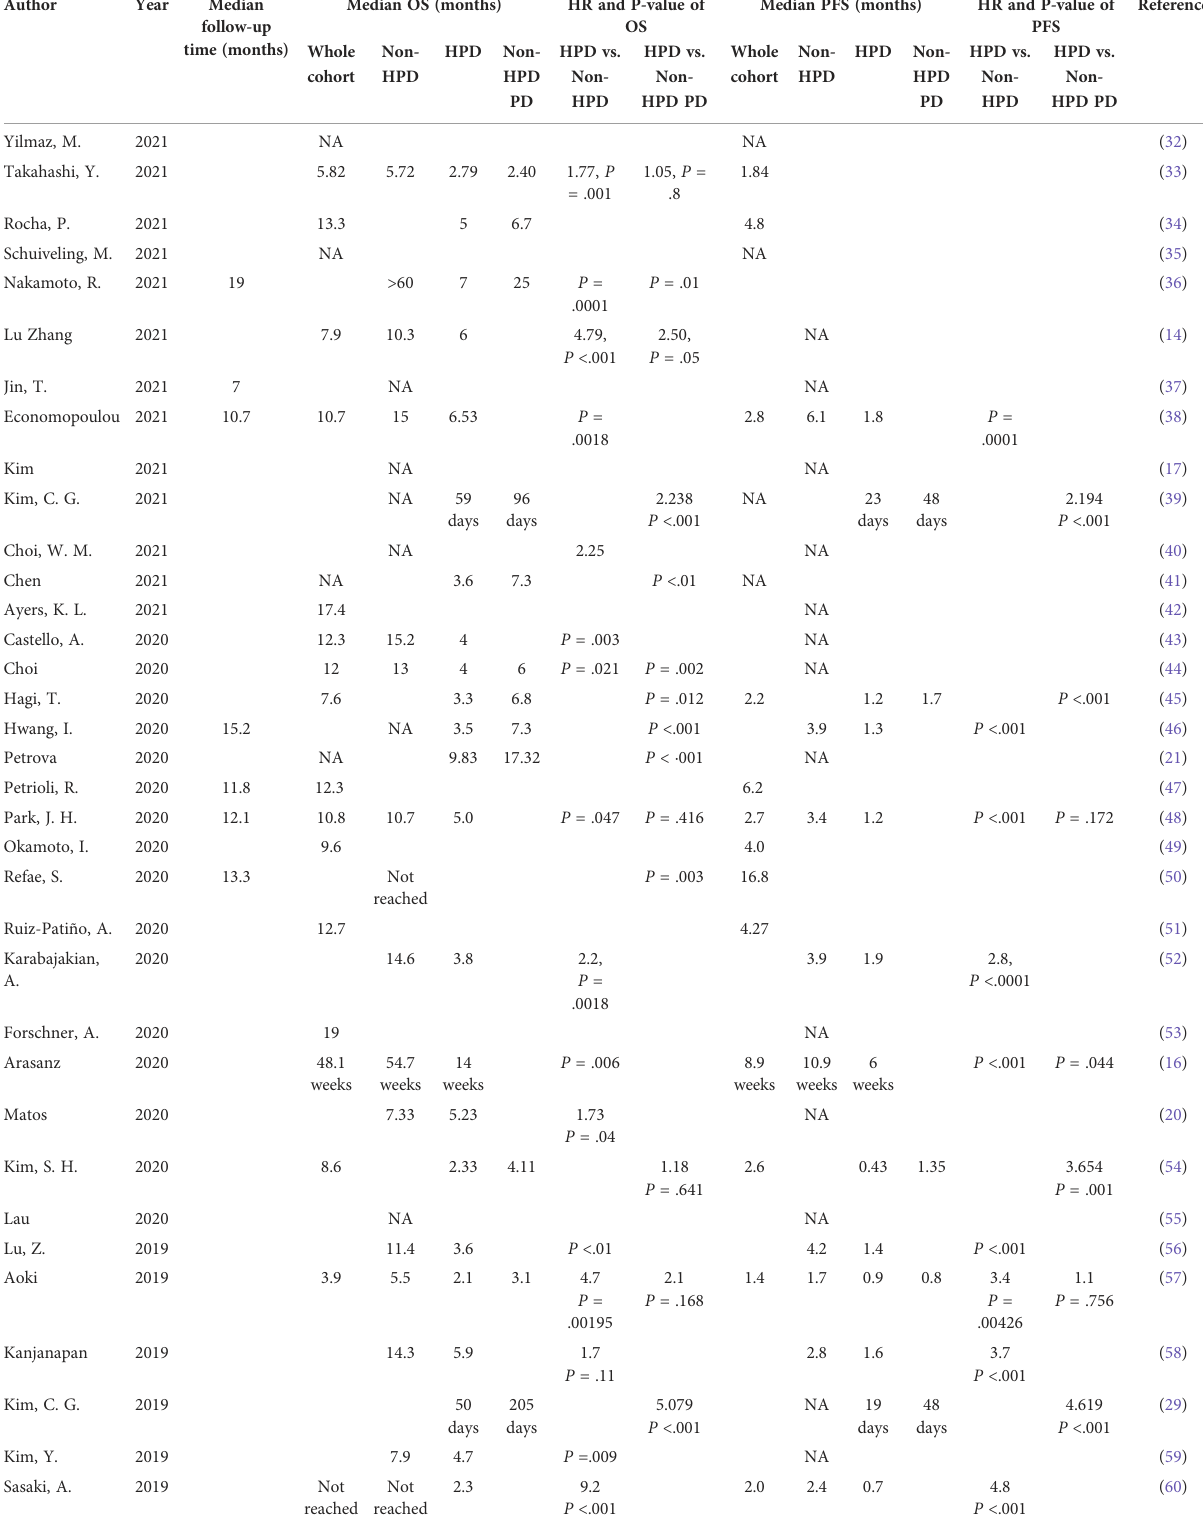
TABLE 3 Data of survival analysis in 41 included